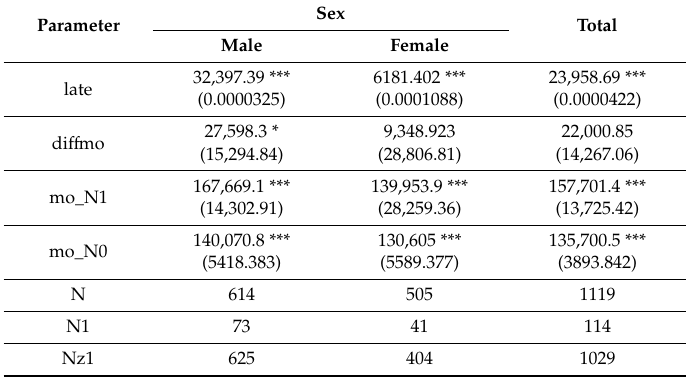
Table 10. Impact of the use of SF on agricultural income.